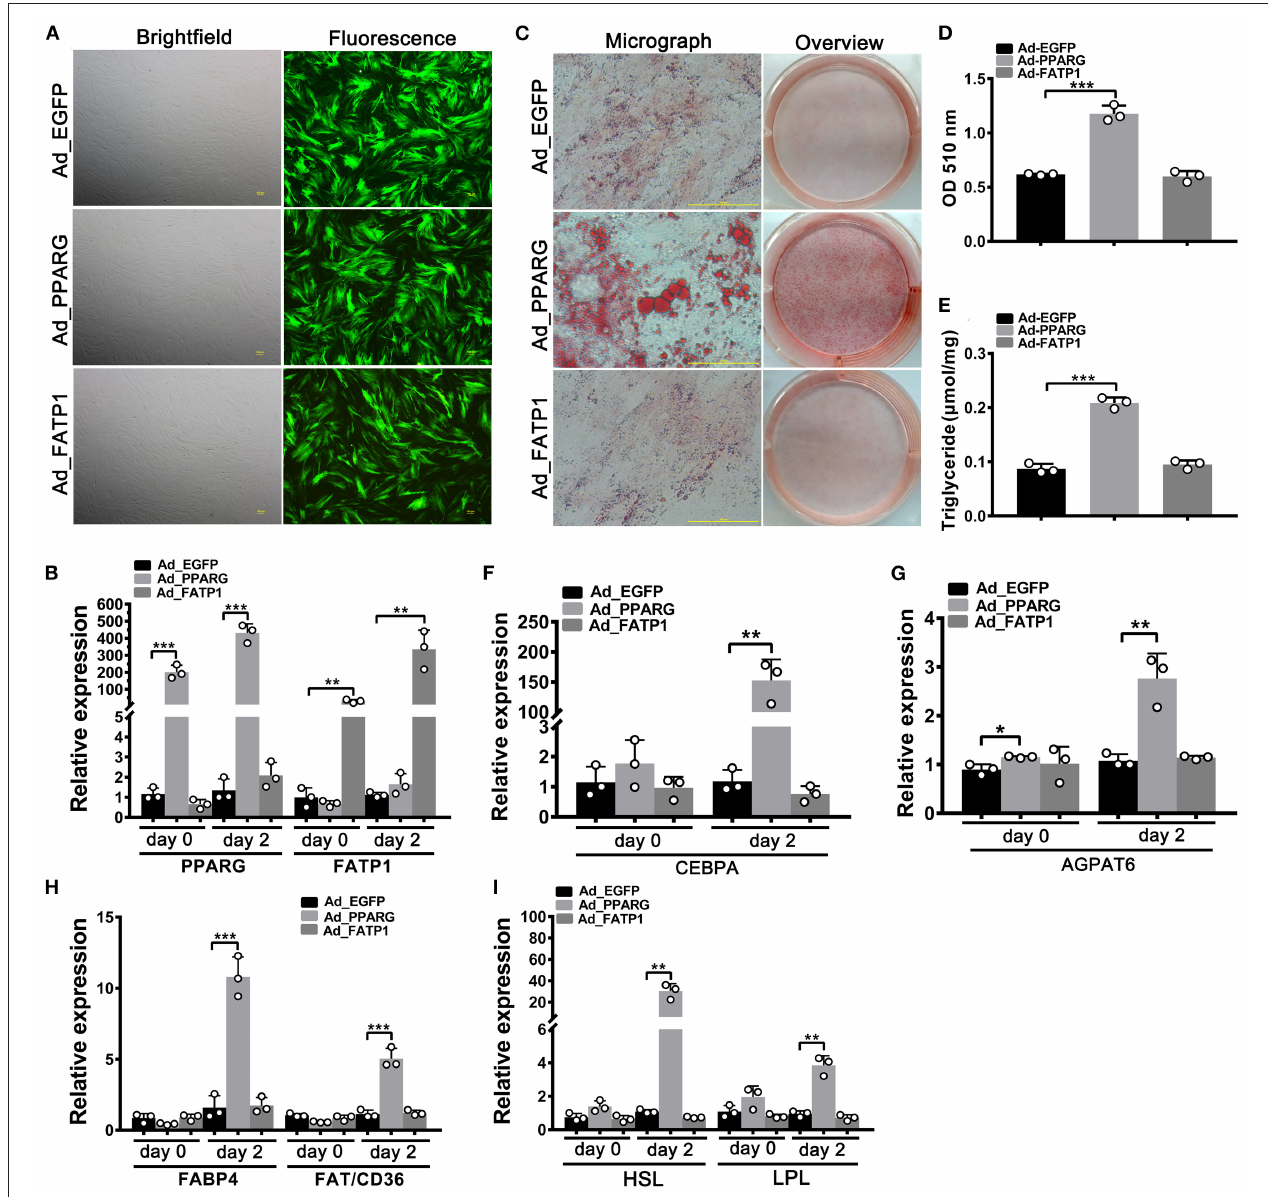
FIGURE 4 | The overexpression of FATP1 does not affect adipogenic differentiation in buffalo subcutaneous preadipocytes. (A) Micrographs of buffalo myocytes on day 2 of adenovirus transduction under bright and fluorescent light. Scale bar, 100 µ m. The mRNA expression levels of PPARG and FATP1 (B) , the adipogenic gene CEBPA (F) , the lipogenic gene AGPAT6 (G) , the fatty acid uptake-related genes FABP4 and FAT / CD36 (H) , and the lipogenesis genes HSL and LPL (I) in the control and experimental groups on day 0 and day 2 of adipogenic trans-differentiation (2 and 4 days after adenovirus transduction, respectively). (C) Oil red O staining of “myocytes” on day 8 of adipogenic trans-differentiation. Scale bar, 100 µ m. (D,E) Quantification of lipid accumulation and triglyceride content in “myocytes” on day 8 of adipogenic trans-differentiation. EGFP overexpression (Ad_EGFP) served as a negative control; PPARG + EGFP overexpression (Ad_PPARG) served as a positive control; FATP1 + EGFP overexpression (Ad_FATP1) served as the experimental group. Data are presented as means ± SD, * p < 0.05, ** p < 0.01, *** p <